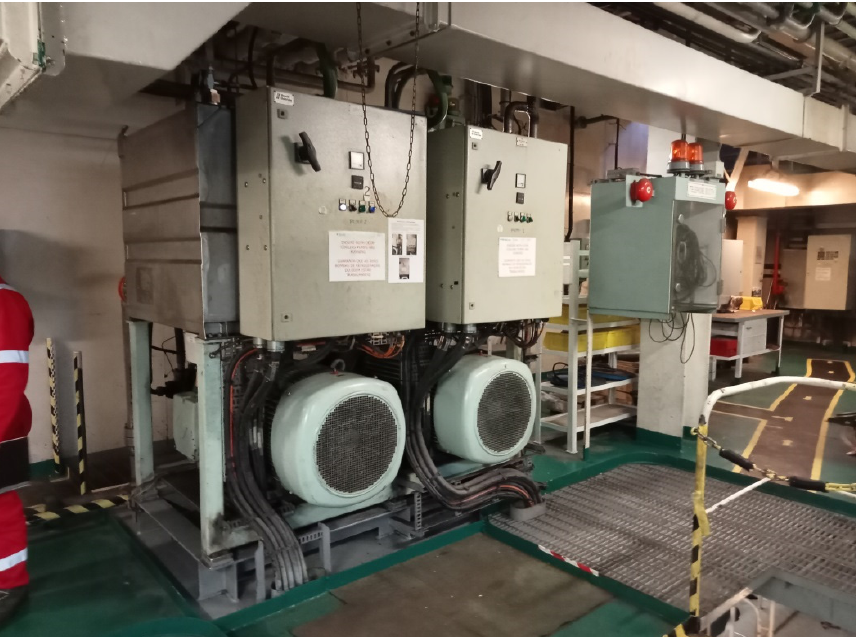
Figure 1. Typical view on the hydraulic twin-two-pump power pack unit on board of the sea ship. Source: shipyard’s own documentation.